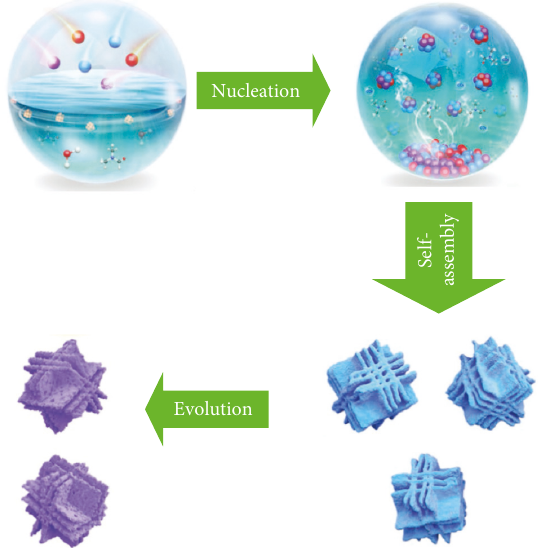
Figure 1: Nanomaterial assembly structure.